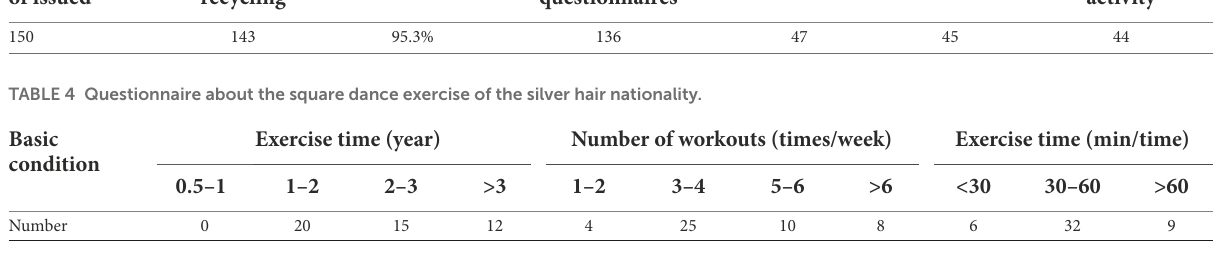
TABLE 5 Participants in square dancing, other sports, non-sports, the silver hair people’s body self-esteem scale. Factor